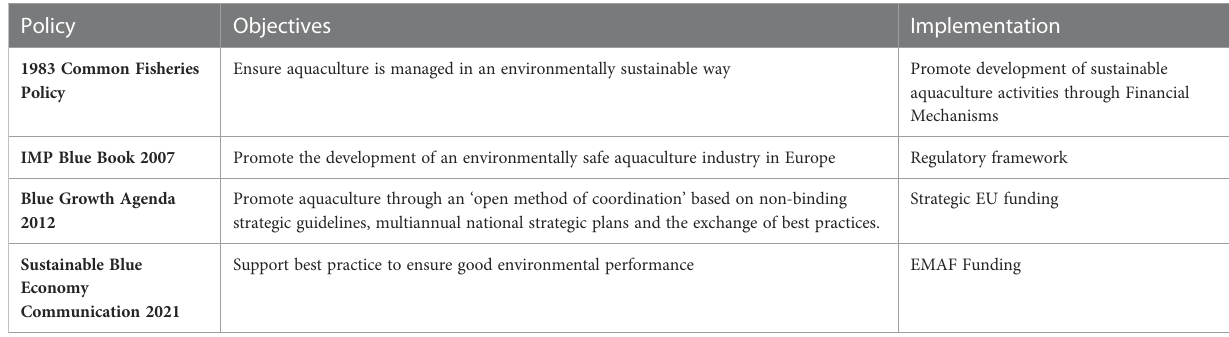
TABLE 1 Key EU policy and law relevant to